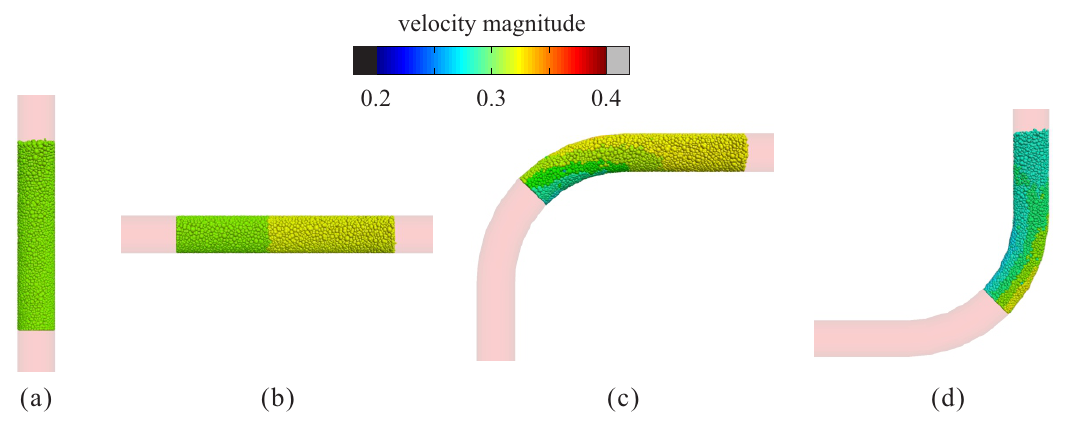
Figure 8. Simulation results of different pipe segments: plot of the velocity magnitude of particles during the stable pumping stage. ( a ) vertical straight pipe; ( b ) horizontal straight pipe; ( c ) upward elbow; and ( d ) downward